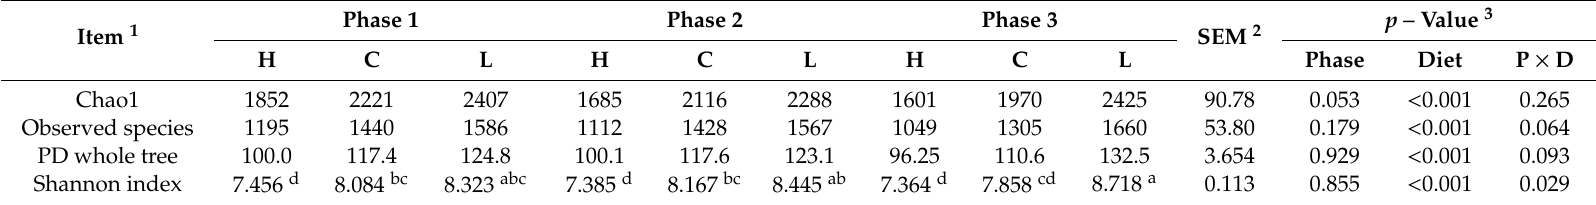
Table 5. E ff ects of dietary nutrient density on alpha diversity metrics in the whole fattening phases of Holstein steers.